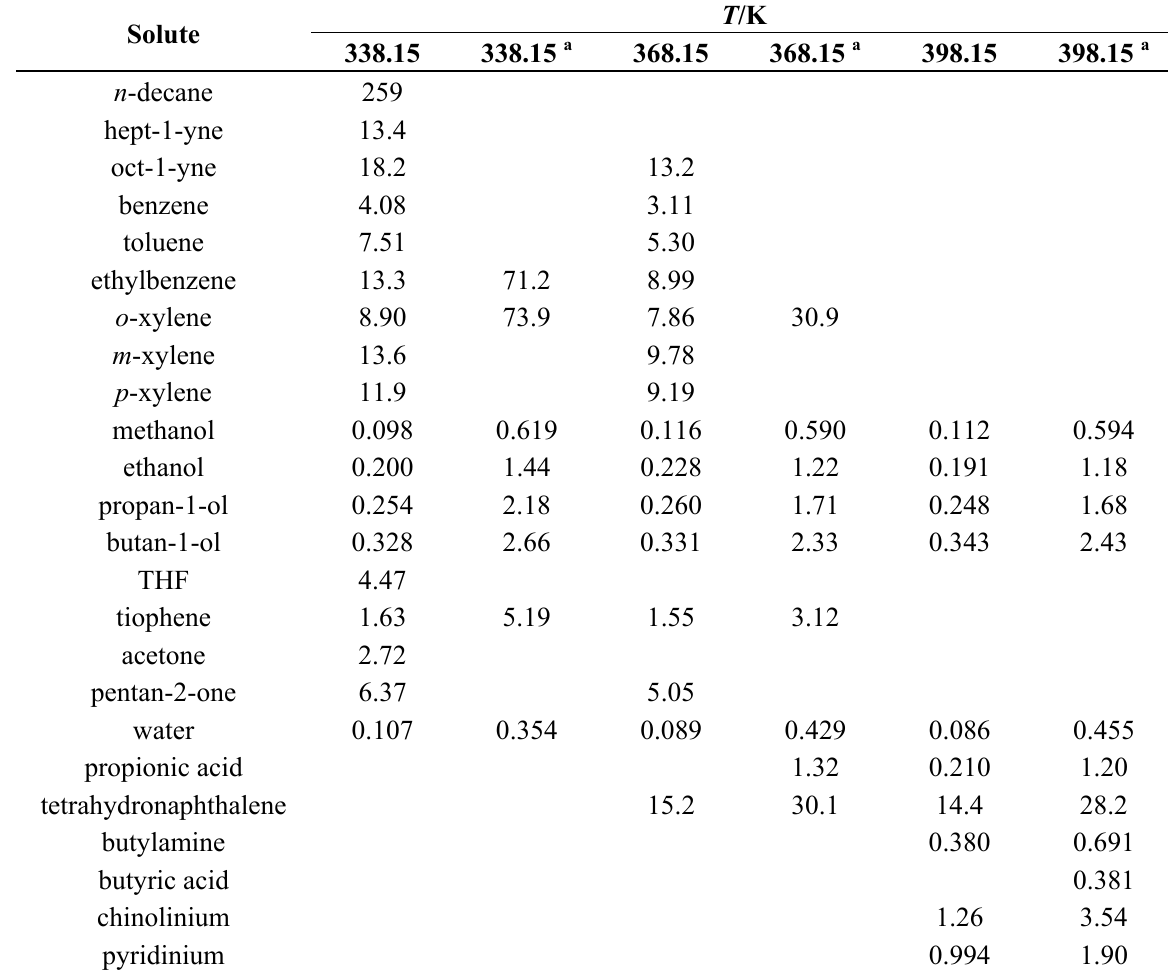
Table 2. The experimental activity coefficients at infinite dilution, ∞ IL [BMPYR][Cl] (15.75 w %) and IL {[BMPYR][Cl] (15.76 w %) + β -CD (14.20 w %)} at different temperatures.